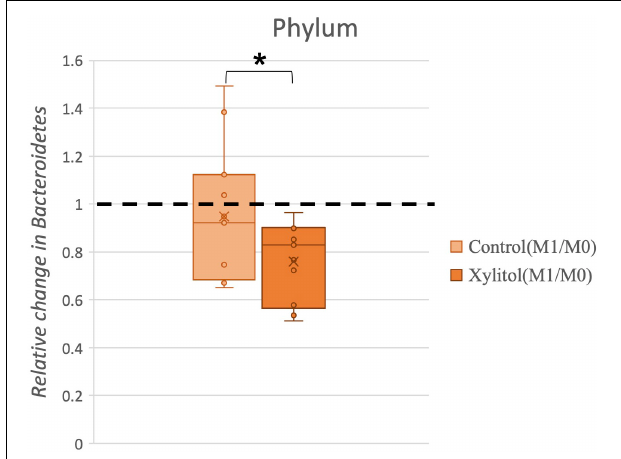
FIGURE 6 | Comparison of the relative change in Bacteroidetes in the control and xylitol groups. The value of abundance of Bacteroidetes for M1 was divided by M0. Error bars indicate the interquartile values, and the dashed line represents the baseline (M0/M0 = 1); “*” indicates p < 0.05 when compared with the baseline using the two-tailed Wilcoxon